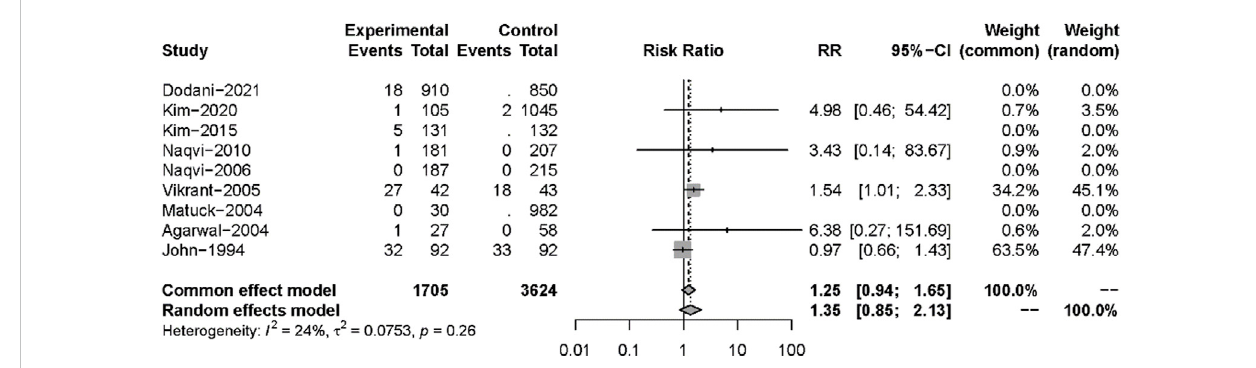
FIGURE 7 Forest plot for outcomes of hepatotoxicity comparing isoniazid versus no